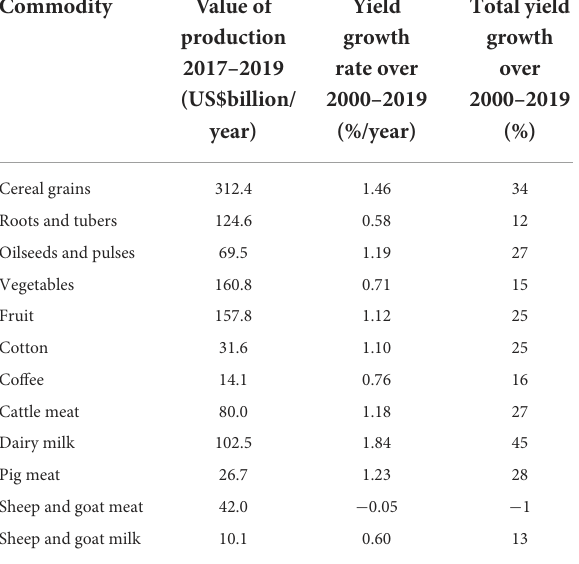
TABLE 1 Historical rates of commodity yield growth in the target